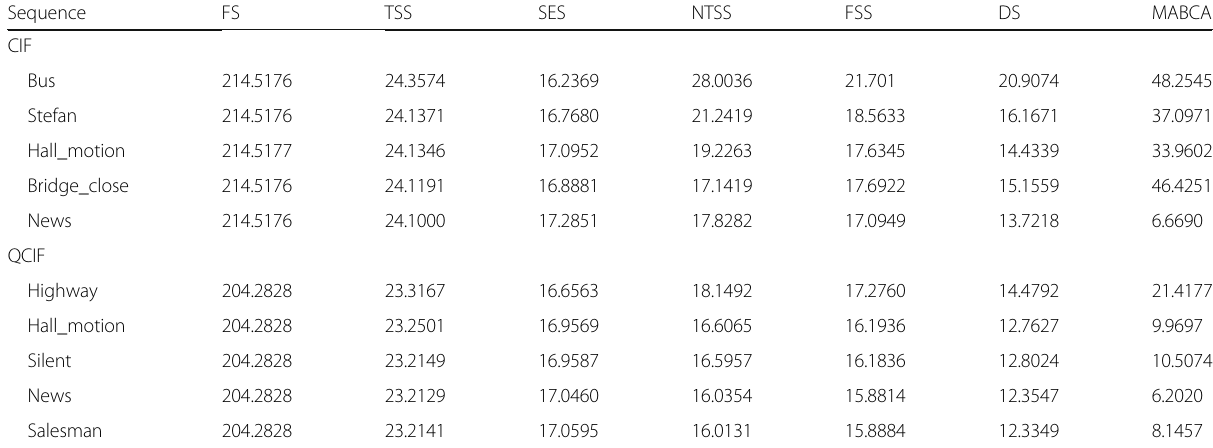
Table 6 The average search point numbers of the 10 video sequences using the seven methods Sequence